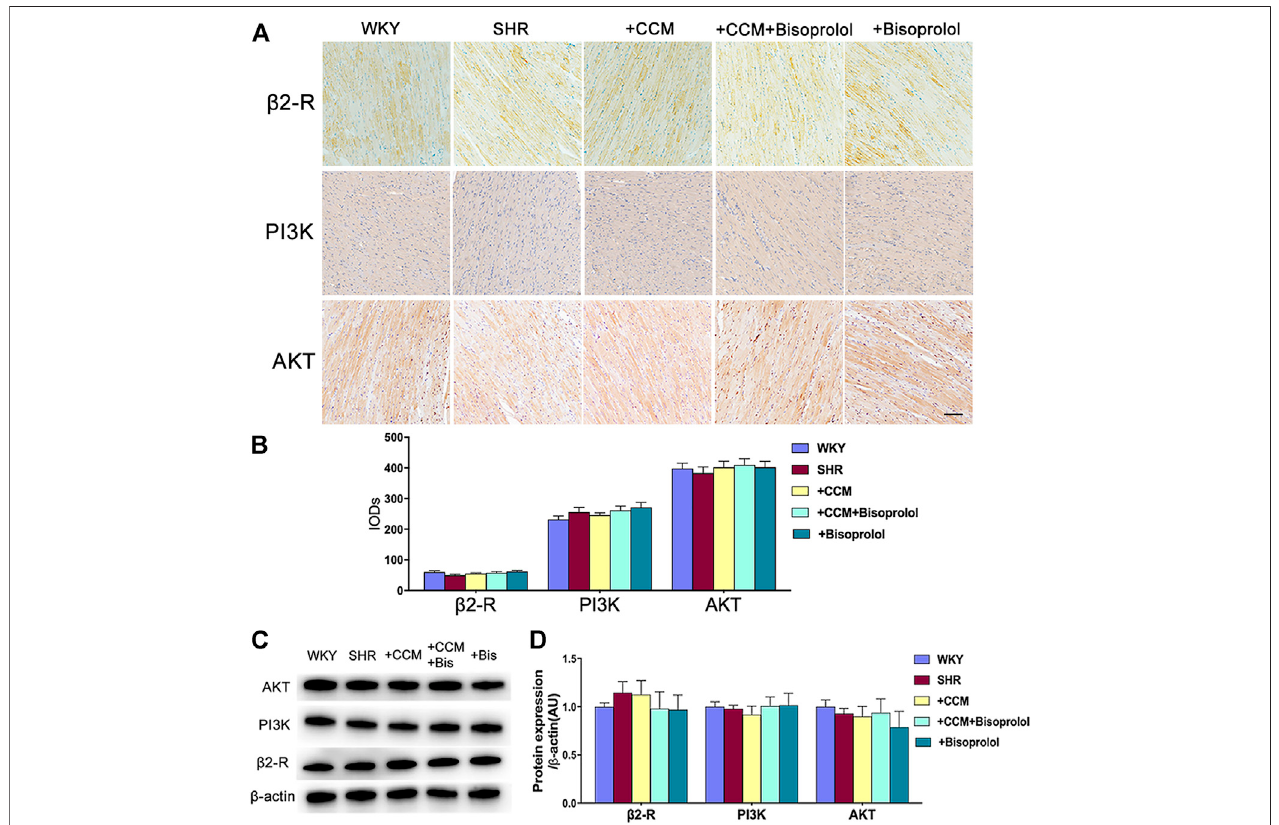
FIGURE 7 | CCM therapy does not alter β 2/PI3K/Akt signaling in SHRs hearts. Male SHRs at the age of 8 – 12 weeks old fed with normal diet received bisoprolol administration (5 mg/kg/day) or plus CCM therapy for 10 weeks. (A,B) Immunohistochemistry and quantitative analysis of β 2/PI3K/Akt signaling in hearts. scale bar: 100 μ m. (C,D) Western blot and quantitative analysis of β 2/PI3K/Akt signaling in hearts. Quantitative results are expressed as mean ± SEM. N is 10 – 15 in each group.